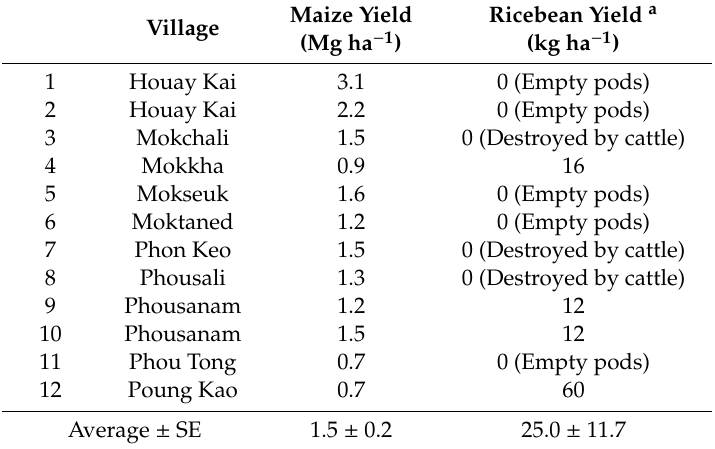
Table 5. Maize and ricebean yields of the twelve farmer-managed field trials. Maize Yield Ricebean Yield a Village (Mg ha − 1 ) (kg ha − 1 ) 1 Houay Kai 3.1 0 (Empty pods) 2 Houay Kai 2.2 0 (Empty pods) Mokchali 1.5 0 (Destroyed by cattle) Mokkha 0.9 1.6 1.2 1.5